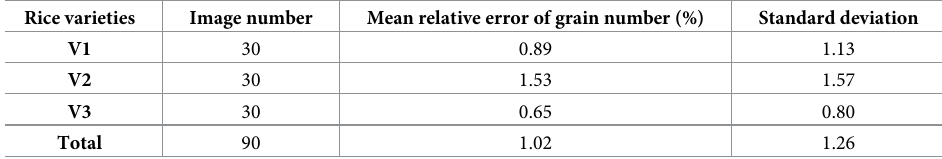
Table 1. The mean relative error of grain number for the three rice